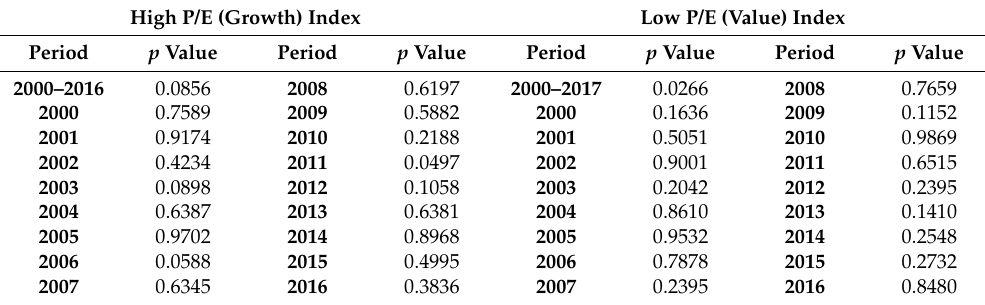
Table 9. Anderson–Darling test results ( p values)—P/E